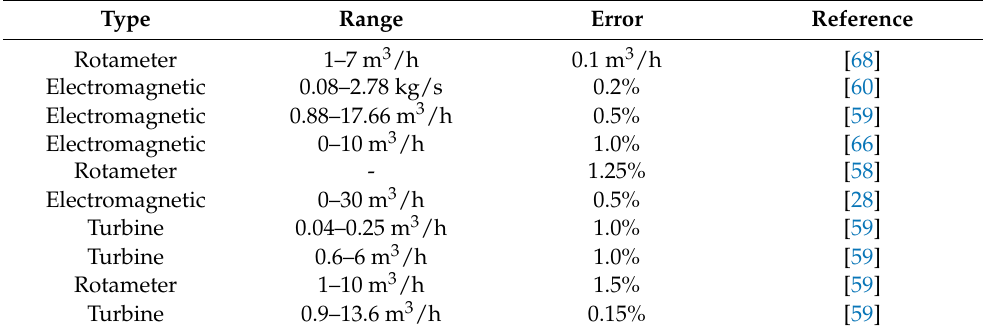
Table 12. Devices used in water flow measurements.